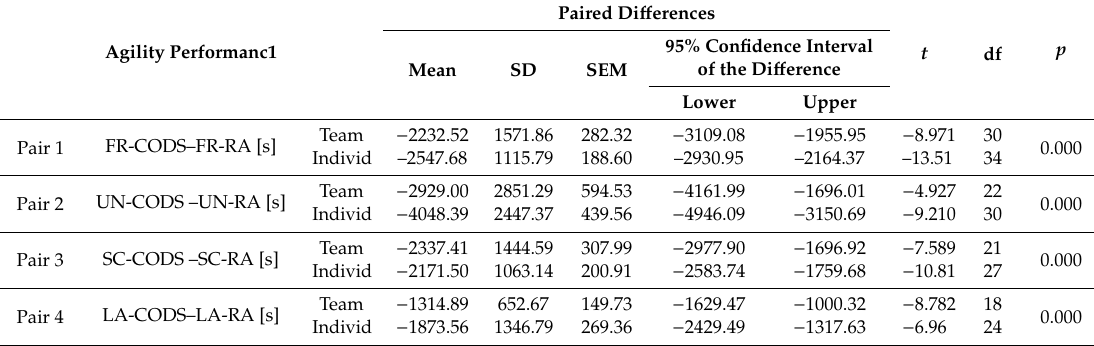
Table 4. Within-group comparisons of change-of-direction speed (CODS) and reactive agility (RA) performance in di ff erent